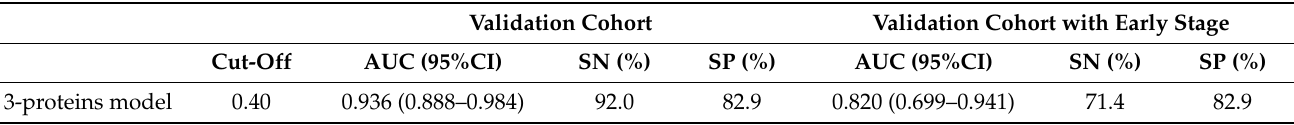
Table 6. Area under the ROC curve of the 3-proteins diagnostic panel in validation cohort.